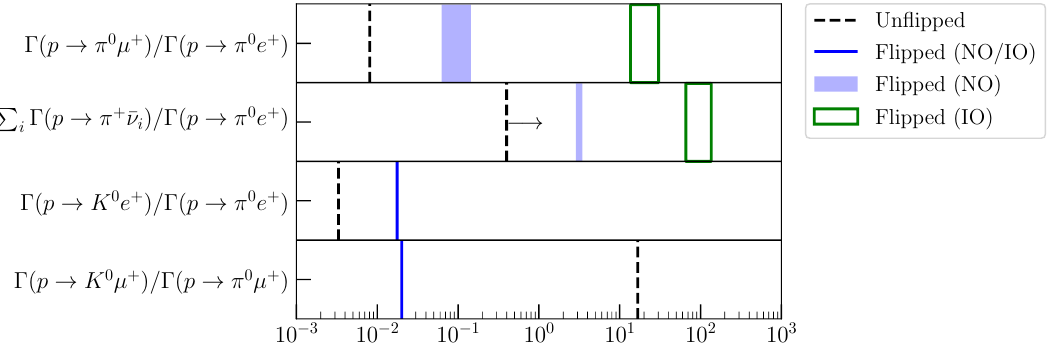
Figure 4 . Compilation of the ratios of proton decay rates predicted in standard un(cid:13)ipped SU(5) (dashed black lines), no-scale (cid:13)ipped SU(5) with neutrino masses that are normal-ordered (NO, blue shading) or inverse-ordered (IO, green boxes). Cases where the (cid:13)ipped SU(5) predictions are independent of the neutrino mass ordering are indicated by solid blue